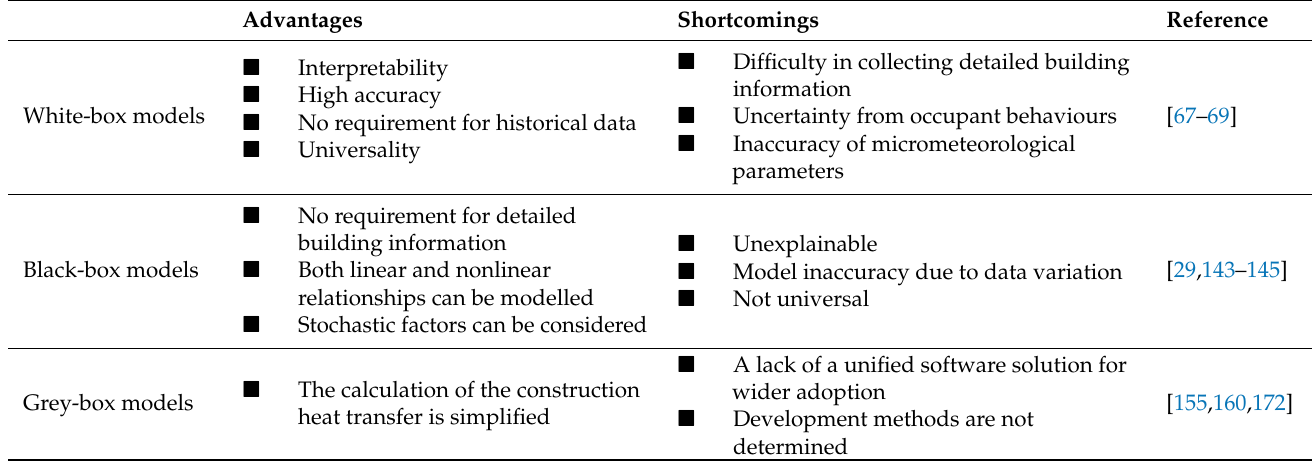
Table 8. Advantages and shortcomings of three types of prediction